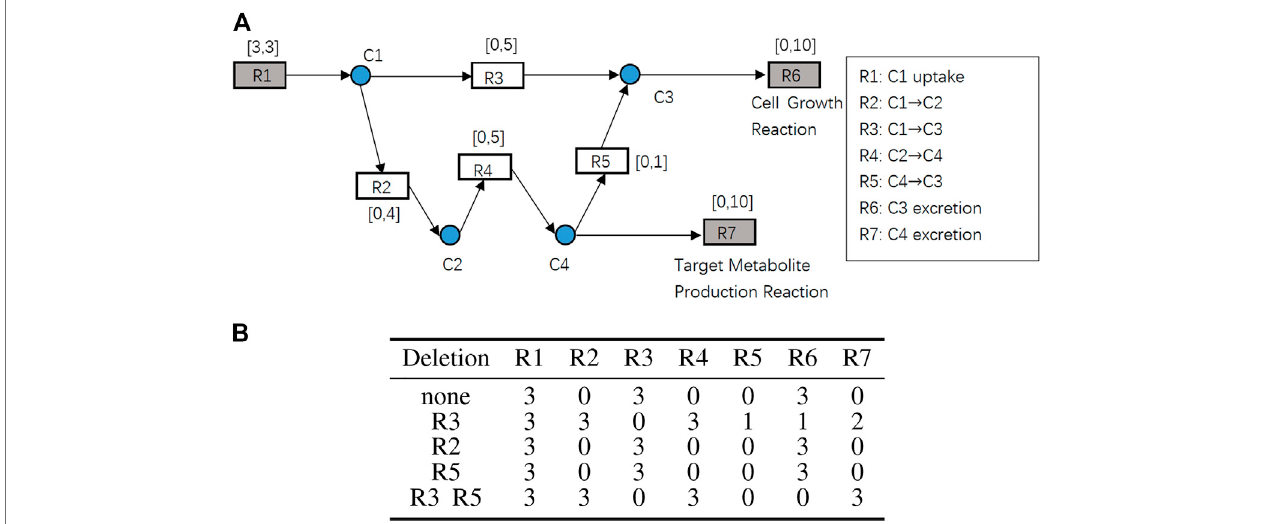
FIGURE 2 | (A) A toy example of the constraint-based models. Rectangular nodes R1 to R7 are reactions, and the attached intervals represent lower and upper boundsoftheirreactionspeeds.R1isthenutrientuptakereaction.R6isthecellgrowthreaction.R7isthetargetmetaboliteproductionreaction.CircularnodesC1toC4 are internal metabolites. (B) Reaction deletion strategies and the resulting fl ux (reaction speed)